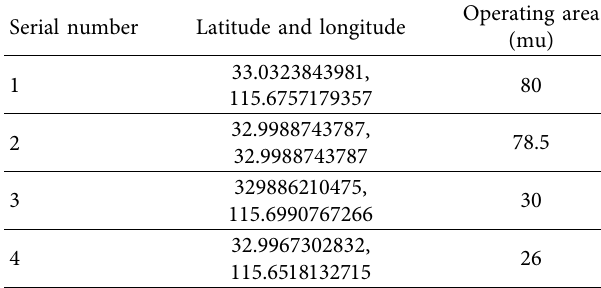
Table 4: Operation field location table.